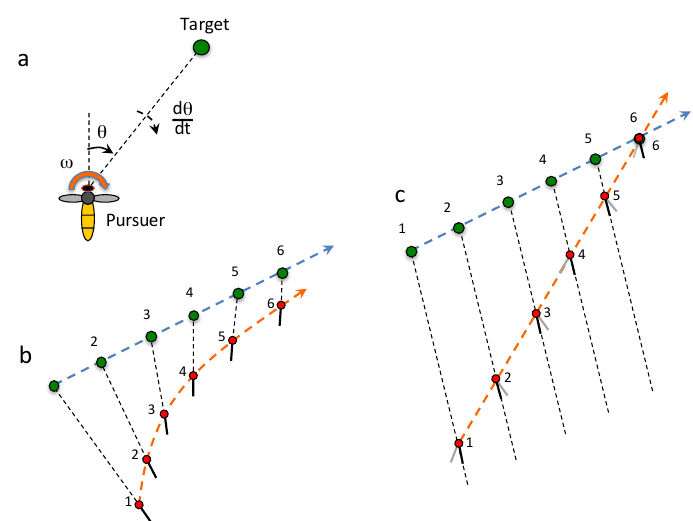
Figure 17. Models characterising pursuit and interception of a moving target. ( a ) Model of pursuit in which the rate of yaw of the pursuer is proportional to the error angle ( θ ), and to the rate of change of the error angle ( d θ ); ( b ) Example of a trajectory in which pursuit is steered according to the model dt in ( a ); ( c ) Example of an interception strategy in which the pursuer maintains the target at a constant absolute bearing. Numbers in ( b ) and ( c ) represent successive (and corresponding) positions of the target (green) and the pursuer (red). Reproduced with permission from